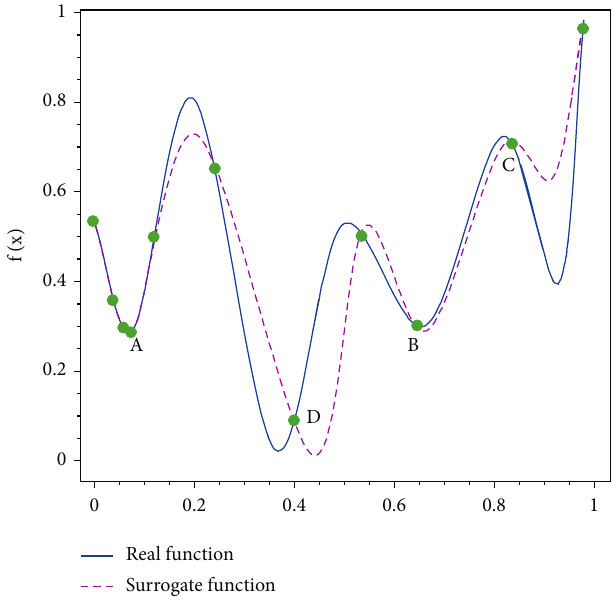
Figure 1: The sketch of local